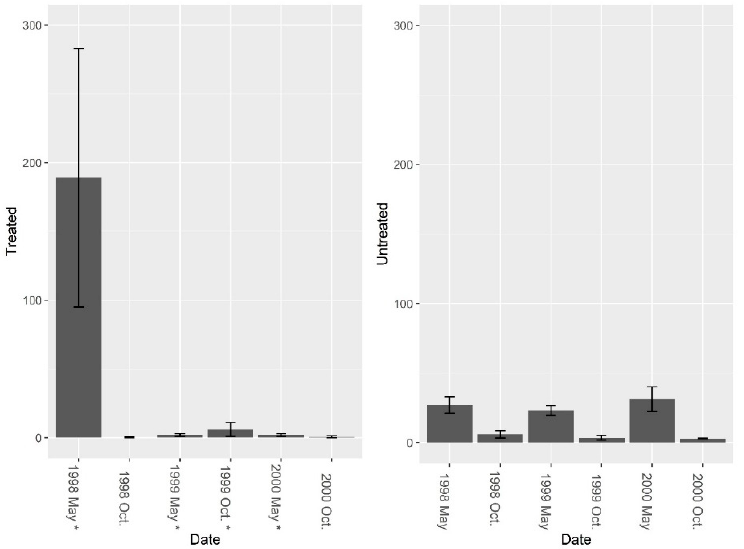
Figure 5. Mean (±1 SE) fire ant abundance collected from burrow vacuuming at five pairs of treated and untreated study sites at CSJFTC, 1998–2000. Fire ant abundance declined 99.9% in treated sites, and decreased 55.6% in untreated sites Pre-treatment fire ant abundance was not significantly different between study sites (F = 2.01, df = 4, P = 0.229). Post-treatment data were compared using a repeated measures randomized block ANOVA, and repeated LOGIC ® applications significantly reduced fire ant abundance (F 1, 7 = 7.37, P = 0.030). Asterisks on the x-axis indicate when treatments occurred.